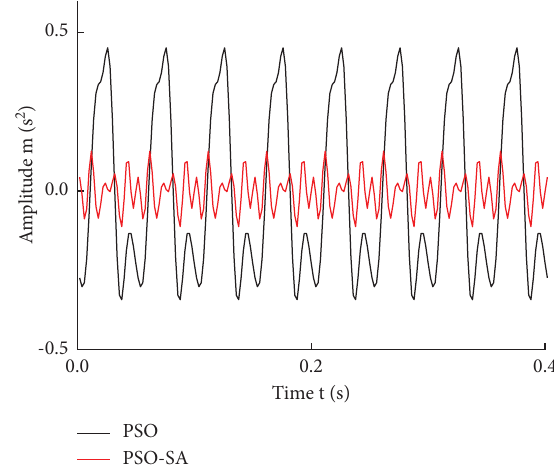
Figure 9: Error comparison curve.